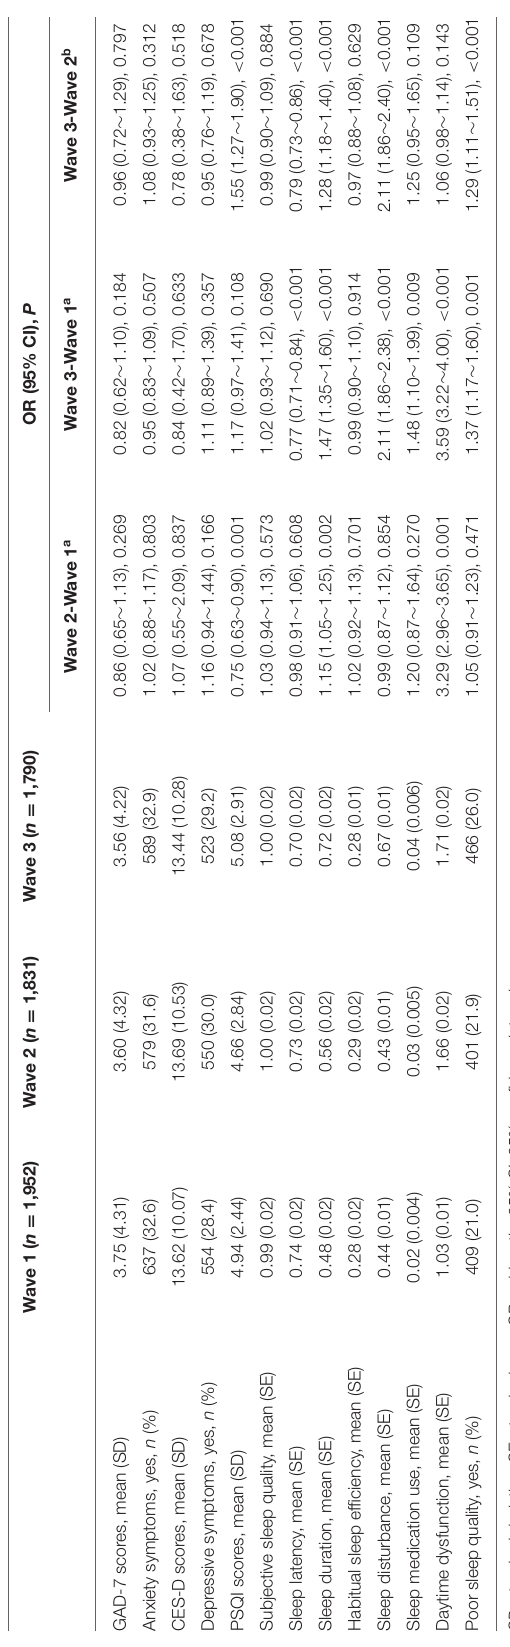
showed significantly positive